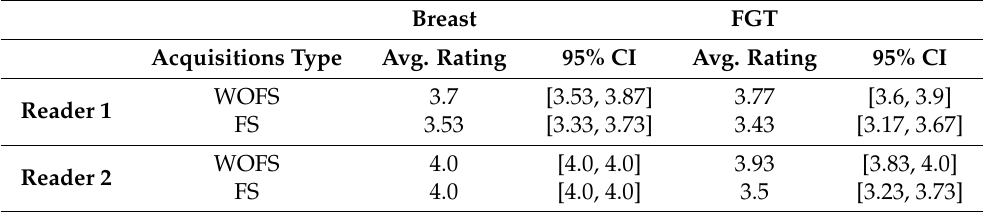
Table 6. External test set results (n = 30 patients, 60 acquisitions (30 WOFS, 30 FS)). Reader study av-